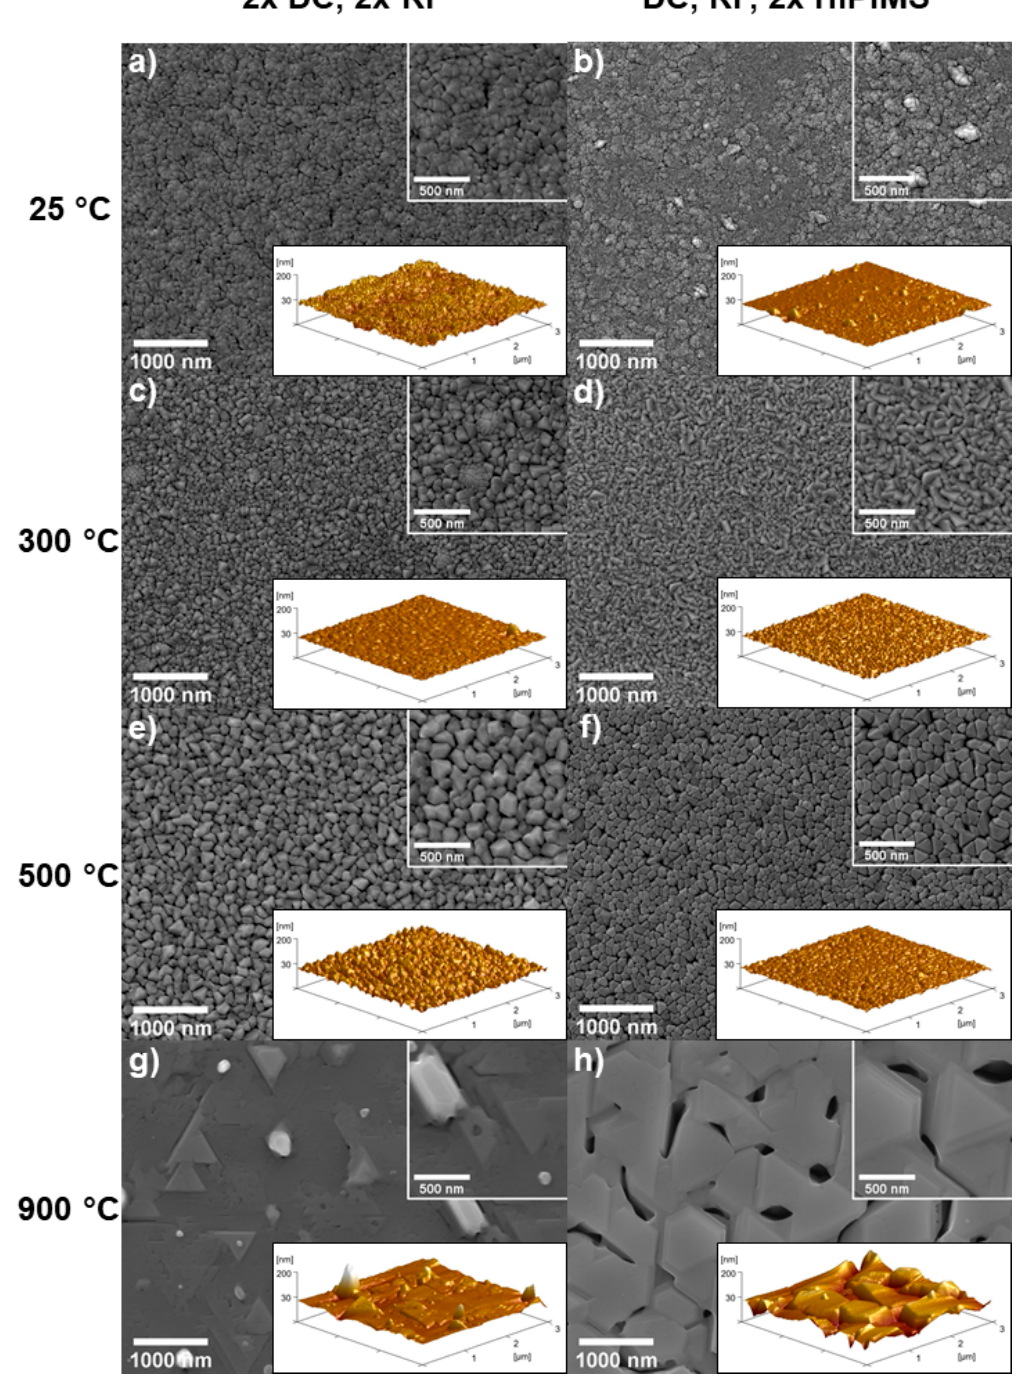
Figure 2. SEM and atomic force microscopy (AFM; inset) images of the surface topography of all CoCrFeNi films. Films shown in the left column ( a , c , e , g ) were grown with two cathodes powered by direct current (DC) and two cathodes powered by radiofrequency (RF) generators. The right column ( b , d , f , h ) films had cathodes powered by one DC, one RF, and two high-power impulse magnetron sputtering (HiPIMS) generators. Substrate temperatures during growth for each condition are indicated for each row.